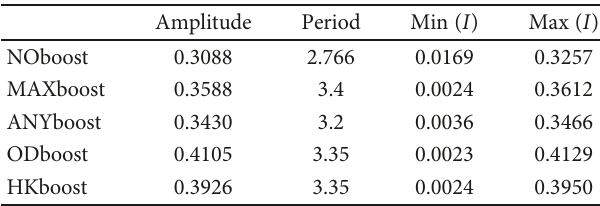
Table 1: Quantitative comparison of the periodic oscillatory solutions ( I component) for changing immune boost mechanism. Oscillation amplitudes and periods, as well as lowest and highest incidence values, are